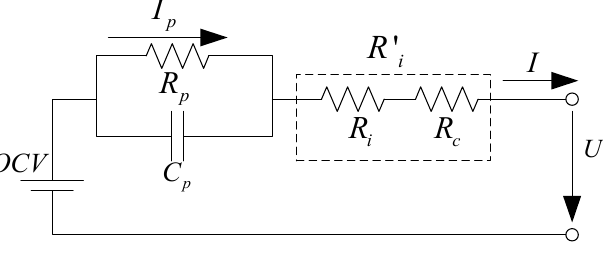
Figure 5. Battery ECM considering contact resistance.